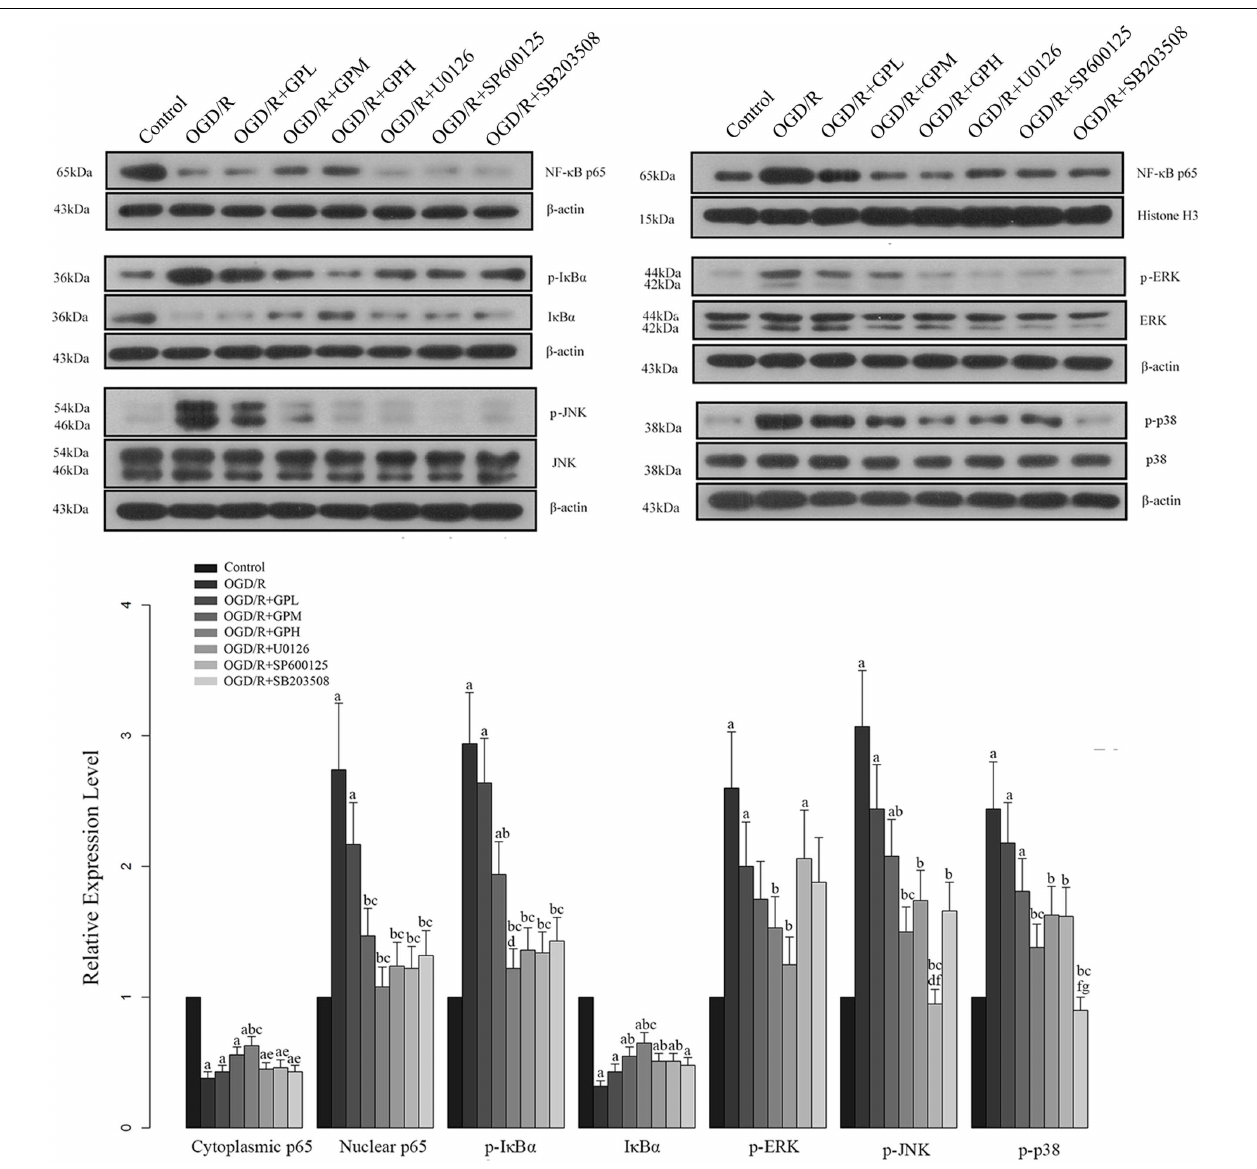
FIGURE 6 | Effect of GP treatment on the expression of molecules involved in the MAPK mediated NF- κ B activation in OGD/R H9c2 cells. a, significantly different from control group, P < 0.05. b, significantly different from OGD/R group, P < 0.05. c, significantly different from OGD/R + GPL group, P < 0.05. d, significantly different from OGD/R + GPM group, P < 0.05. e, significantly different from OGD/R + GPH group, P < 0.05. f, significantly different from OGD/R + U0126 group, P < 0.05. g, significantly different from OGD/R + SP600125 group, P <